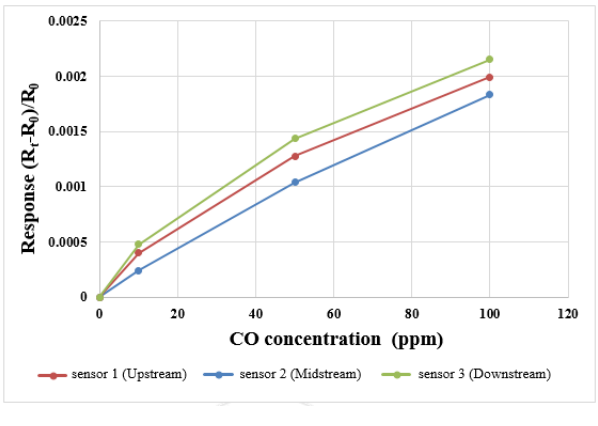
Figure 7. CO correction curve.